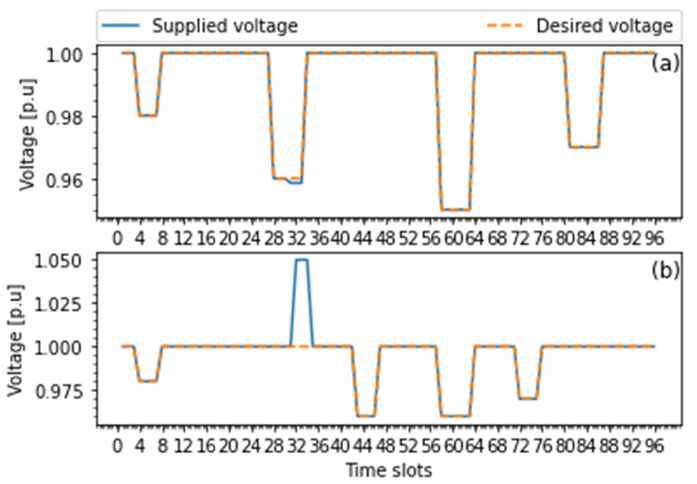
Figure 10. Voltage regulation with different load conditions: ( a ) normal condition; ( b ) uncertain condition.